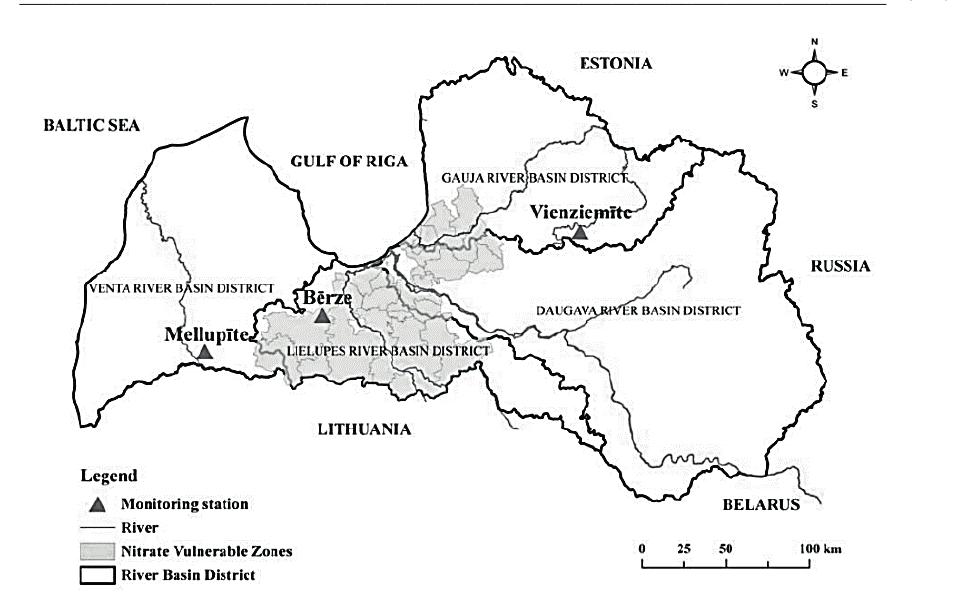
Fig. 1. Location of the monitoring sites at Berze, Mellupite and Vienziemite